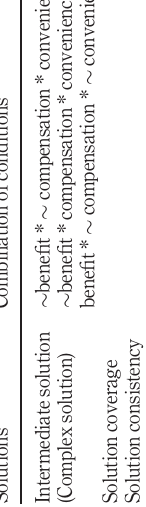
Table V. Formation path of negative externalities in the sharing